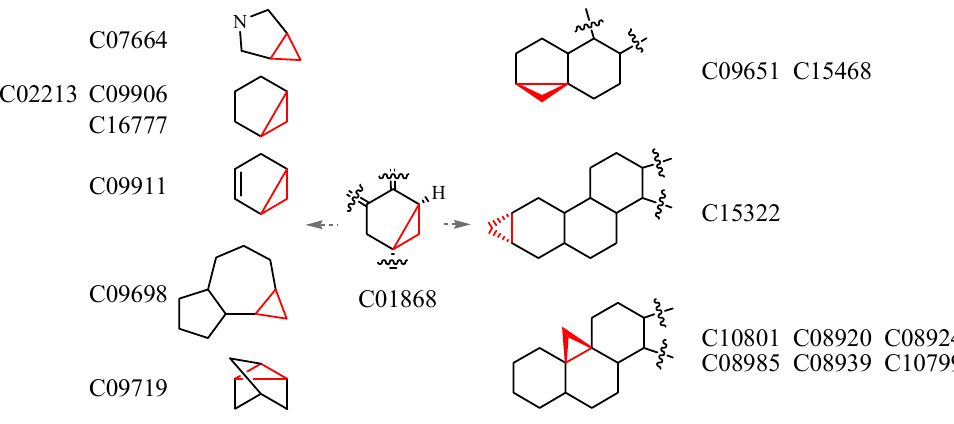
Figure 2. Structural diversity derived from the localization and structure type difference (partial structure of each